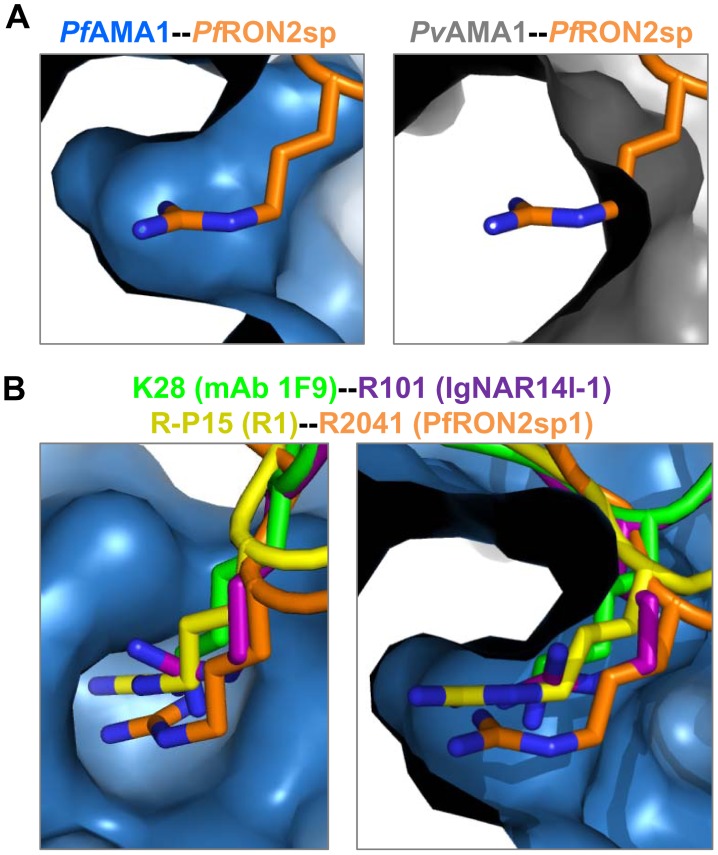
The Arg knob-in-hole interaction is critical for species selectivity and interaction with invasion inhibitory antibodies and peptides.(A). Left - A cut-away surface of PfAMA1 (blue), reveals that Arg2041 of PfRON2sp1 (orange) integrates deeply into a well-defined pocket. Right - However, no analogous pocket is observed in PvAMA1 (grey; PDB ID 1W8K). (B). Peptides and antibodies known to be invasion inhibitory for P. falciparum occupy the key Arg binding site, as shown by orthogonal views of the PfAMA1-PfRON2sp1 co-structure (blue-orange) overlayed with the mAb 1F9 co-structure (1F9, green; PDB ID 2Q8B), IgNAR14l-1 co-structure (IgNAR, purple; PDB ID 2Z8V), and R1 co-structure (R1, yellow; reported here).